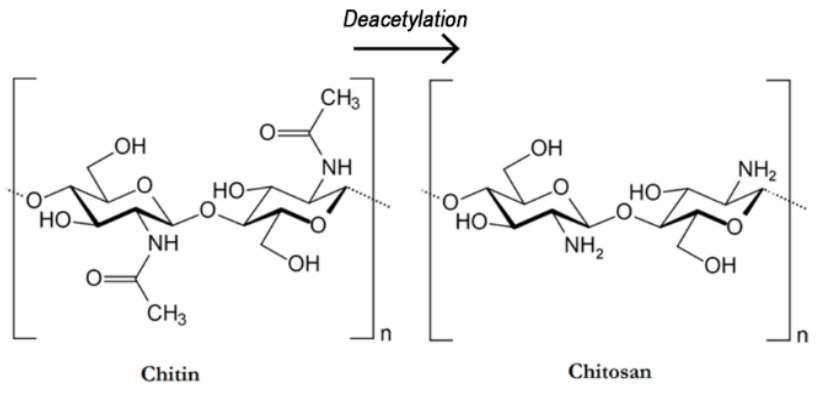
Figure 1. Chemical Structure of Chitin and Chitosan.